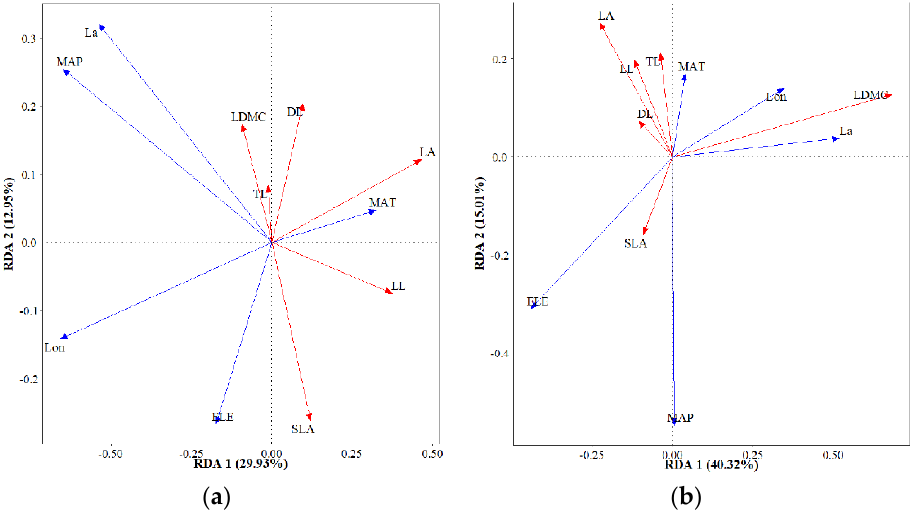
Figure 5. Redundancy analysis based on needle traits of ( a ) P. massoniana and ( b ) P. hwangshanensis . Abbreviations: Lon: longitude, La: latitude, ELE: elevation, MAT: annual average temperature, MAP: annual precipitation.